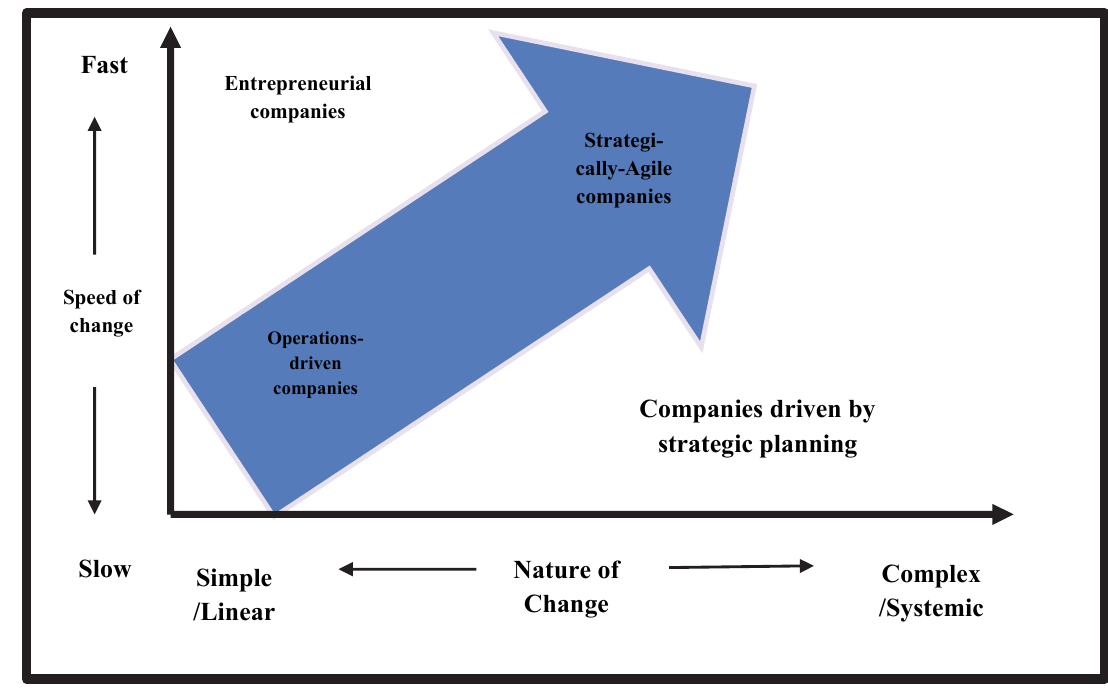
Fig. 1. Responses to Change (Doz and Kosonen,